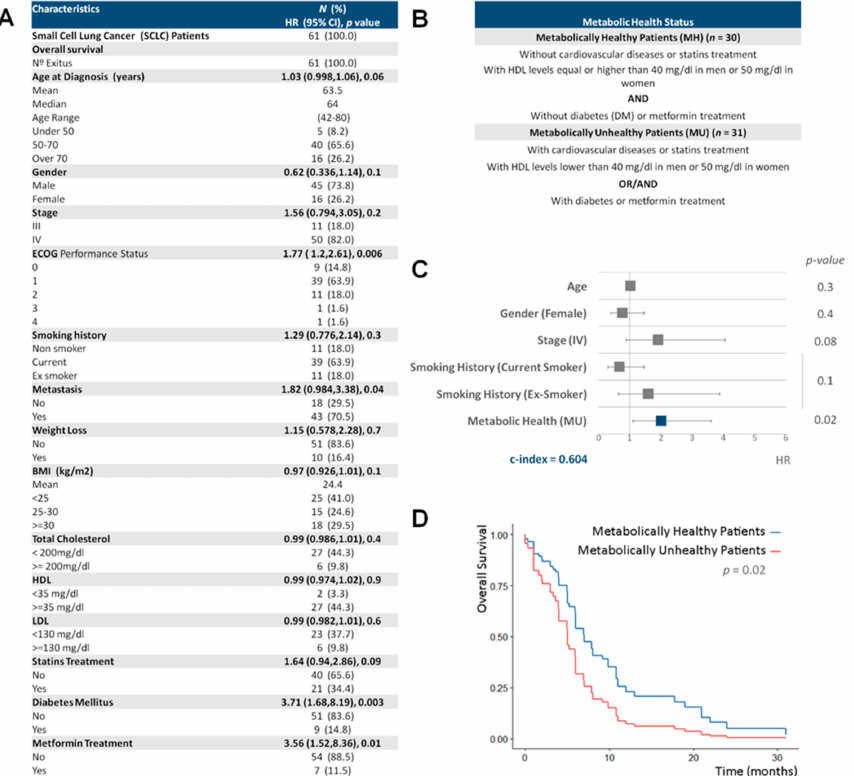
Figure 1. Associations between small cell lung cancer (SCLC) survival and metabolic health. ( A ) Clinical characteristics of 61 small cell lung cancer patients. Univariate Cox regression analysis was used to test the association between overall survival and clinical variables. BMI: body mass index, ECOG: eastern cooperative oncology group, HDL: high-density lipoprotein and LDL: low-density lipoprotein. ( B ) Participant characteristics by metabolic health status. ( C ) Forest plot showing the hazard ratio (HR) and 95% confidence interval (CI) estimates for the overall survival (OS) of clinical characteristics and metabolic health status in 61 SCLC patients. HR, their 95%CI and p -values were calculated from multivariable Cox regression model; the latter were obtained after a marginal likelihood-ratio test for each factor, further corrected for multiple test by using the Bonferroni method. ( D ) Conditionally adjusted survival curves for SCLC overall survival by metabolic health status from the previous